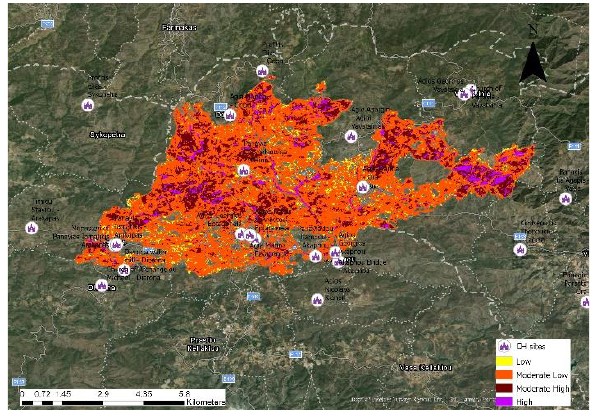
Figure 9 Map of the differenced Normalized Burn Ratio and the distribution of cultural heritage sites Table 3 CH sites and the average distance from the burned area Figure 10 An example at Agia Marina (Eptagoneia) for buffer Average Distance zones in 0.5Km, 1Km and 2Km for the identification of the CH site - Village from the neighbour severity Burned area